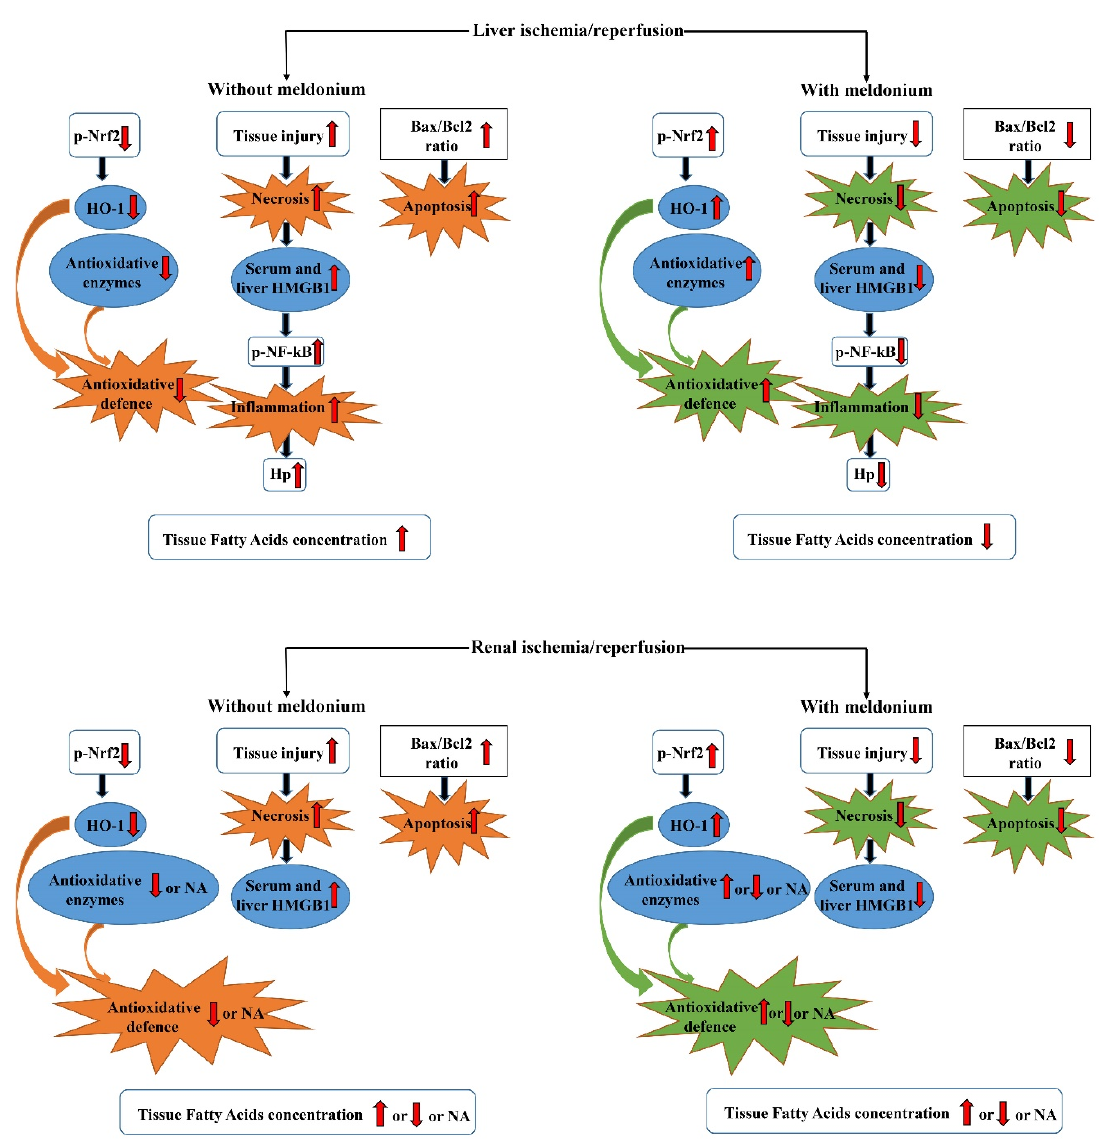
Figure 2. The summarized effects of meldonium on the hepatic and renal ischemia/reperfusion. p-Nrf2—phosphorylated nuclear factor erythroid 2-related factor 2; HO-1—haem oxygenase; HMGB1—high mobility group Box 1 protein; p-NF-kB p65—phosphorylated nuclear factor kappa-light-chain-enhancer of activated B cells; BAX—pro-apoptotic member of Bcl2 gene family; Bcl2—anti-apoptotic member of Bcl2 gene family. Upward pointing arrow ( ↑ ) indicates an increase, downward pointing arrow ( ↓ ) indicates a decrease, and NA indicates no